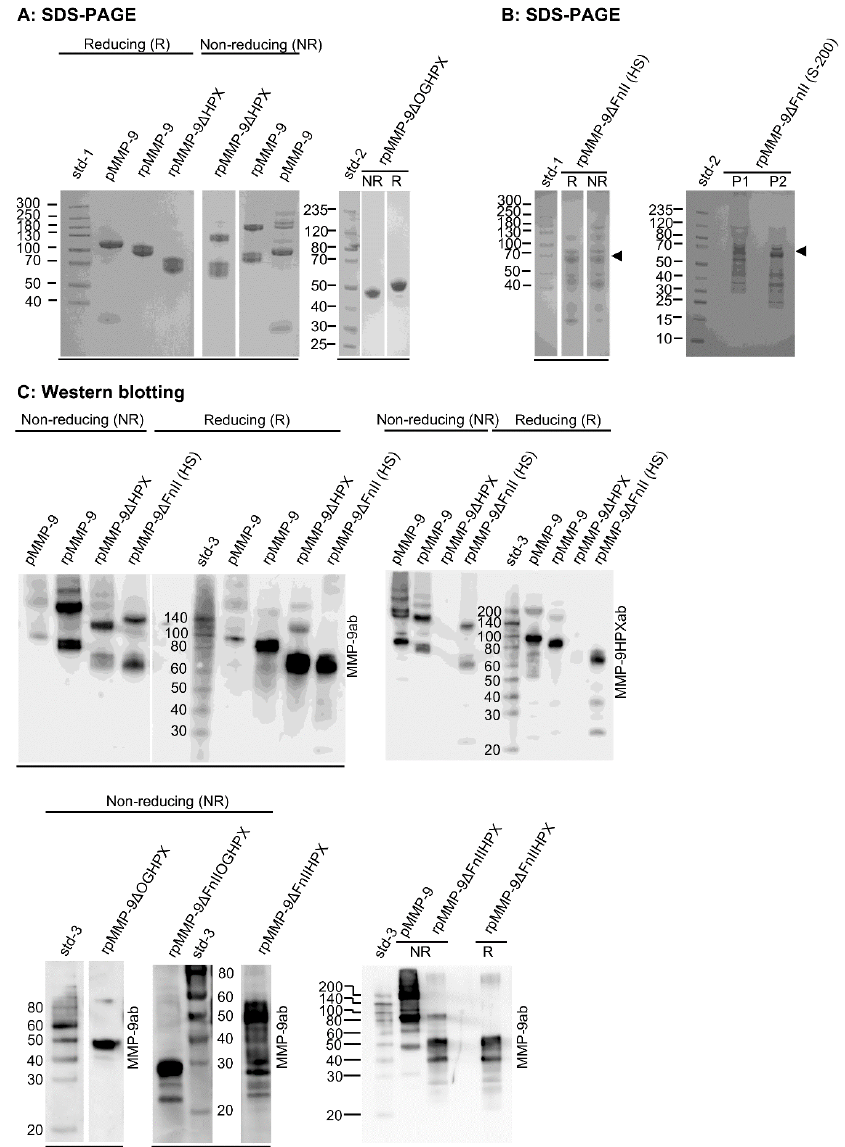
Figure 2. SDS-PAGE and Western blot analysis of recombinant proMMP-9 variants. After purification, the different recombinant proMMP-9 (rpMMP-9) variants shown in Figure 1 were analyzed by Imperial stained SDS-PAGE ( A , B ) and Western blotting ( C ). To determine the purity, the molecular mass, as well as the presence of monomers and homomultimers, reducing (R) and non-reducing (NR) conditions were used. As a control, purified pMMP-9 (proMMP-9 from THP-1 cells) was used, which also contained small amounts of TIMP-1 (30 kDa), as seen in ( A ). Std-1 and Std-2 are the high range and broad range molecular weight standards from Thermo Scientific, respectively, with the molecular weights in kDa shown ( A , B ), and Std-3 in ( C ) is the biotinylated protein ladder. In ( C ), MMP-9ab and MMP-9HPXAb are polyclonal antibodies against the entire enzyme and the C-terminal HPX domain, respectively. In ( B , C ), recombinant proMMP-9 ∆ FnII is purified on either a Sephacryl-S-200 column (rpMMP-9 ∆ FnII (S-200)) or a heparin-Sepharose column (rpMMP-9 ∆ FnII (HS)), as described in the Materials and Methods. In ( C ), the crude media of two FnII-deletion variants (rpMMP-9 ∆ FnIIHPX and rpMMP-9 ∆ FnIIOGHPX) are used. In ( B ), the arrowhead shows the position of the rpMMP-9 ∆ FnII monomer. P1 and P2 are pooled non-reduced fractions from the S-200 column, and both contained rpMMP-9 ∆ FnII based on gelatin zymography. The line under gels indicates that the samples are from the same gel, which was cut and pasted for the sake of clarity in